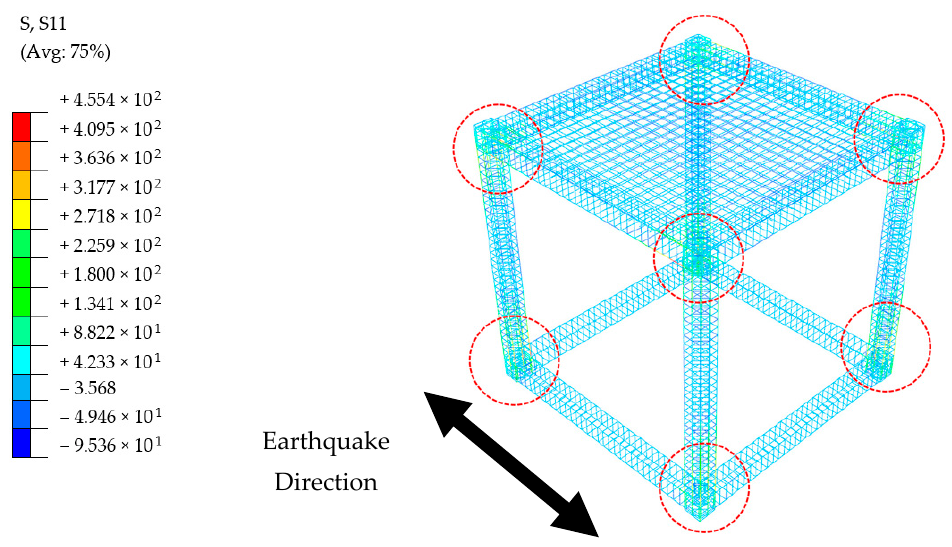
Figure 23. Reinforcement stresses belong to BF Building [MPa]; circles indicate the highest stress concentrations.